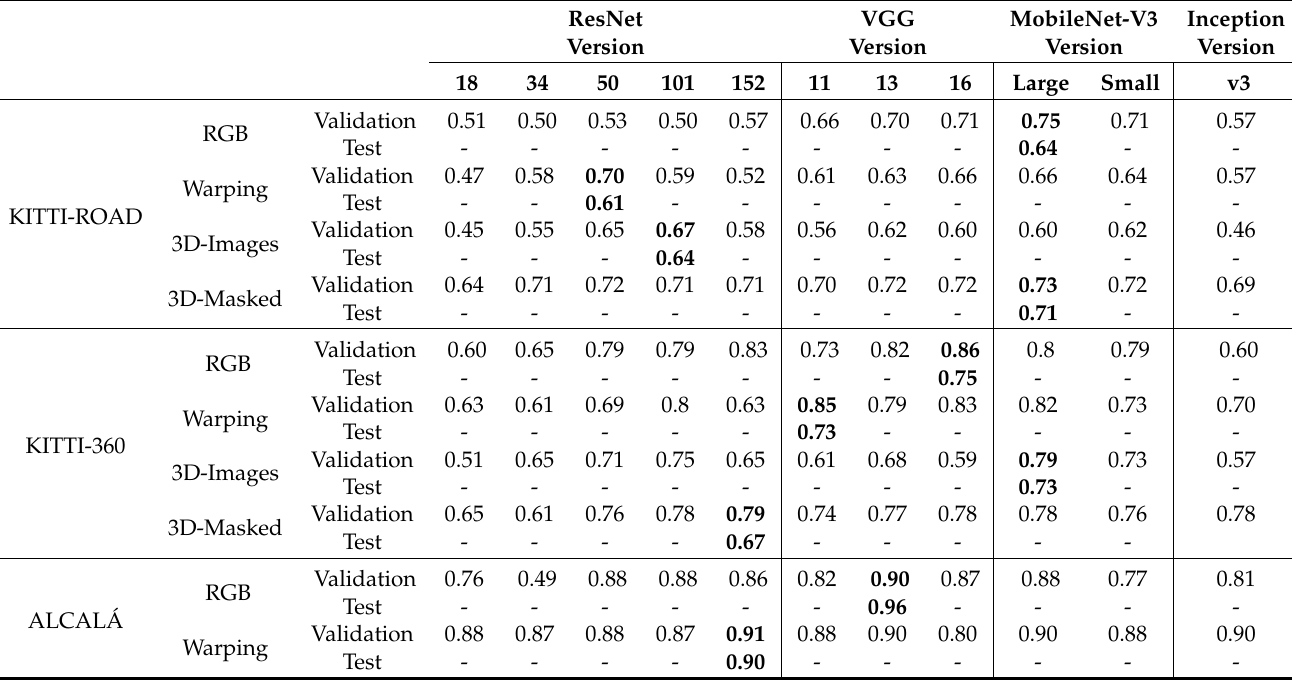
Table 4. Teacher/student paradigm